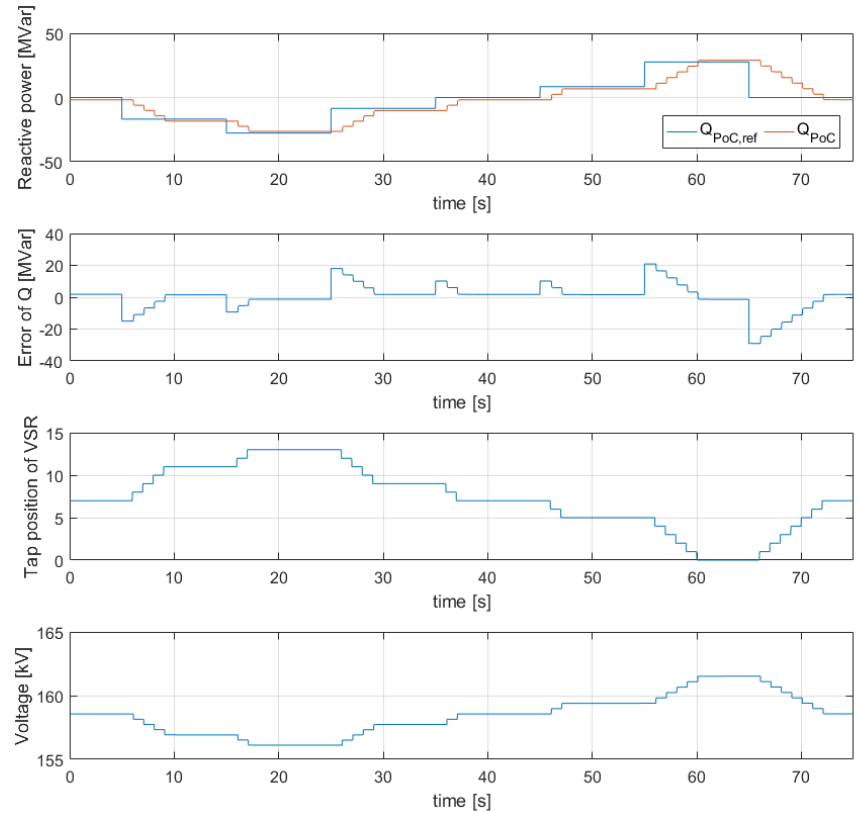
Figure 14. Set–point change control response of reactive power using only a VSR.